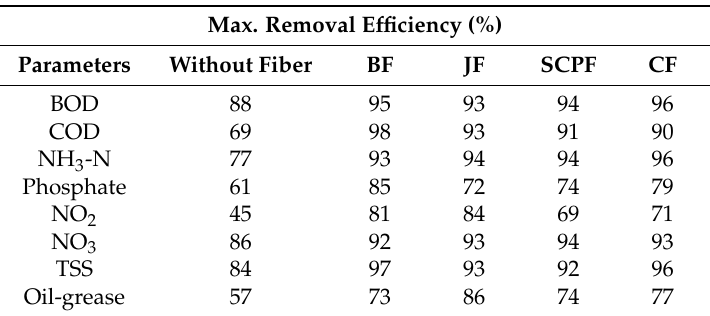
Table 4. Summary of maximum removal efficiencies for all